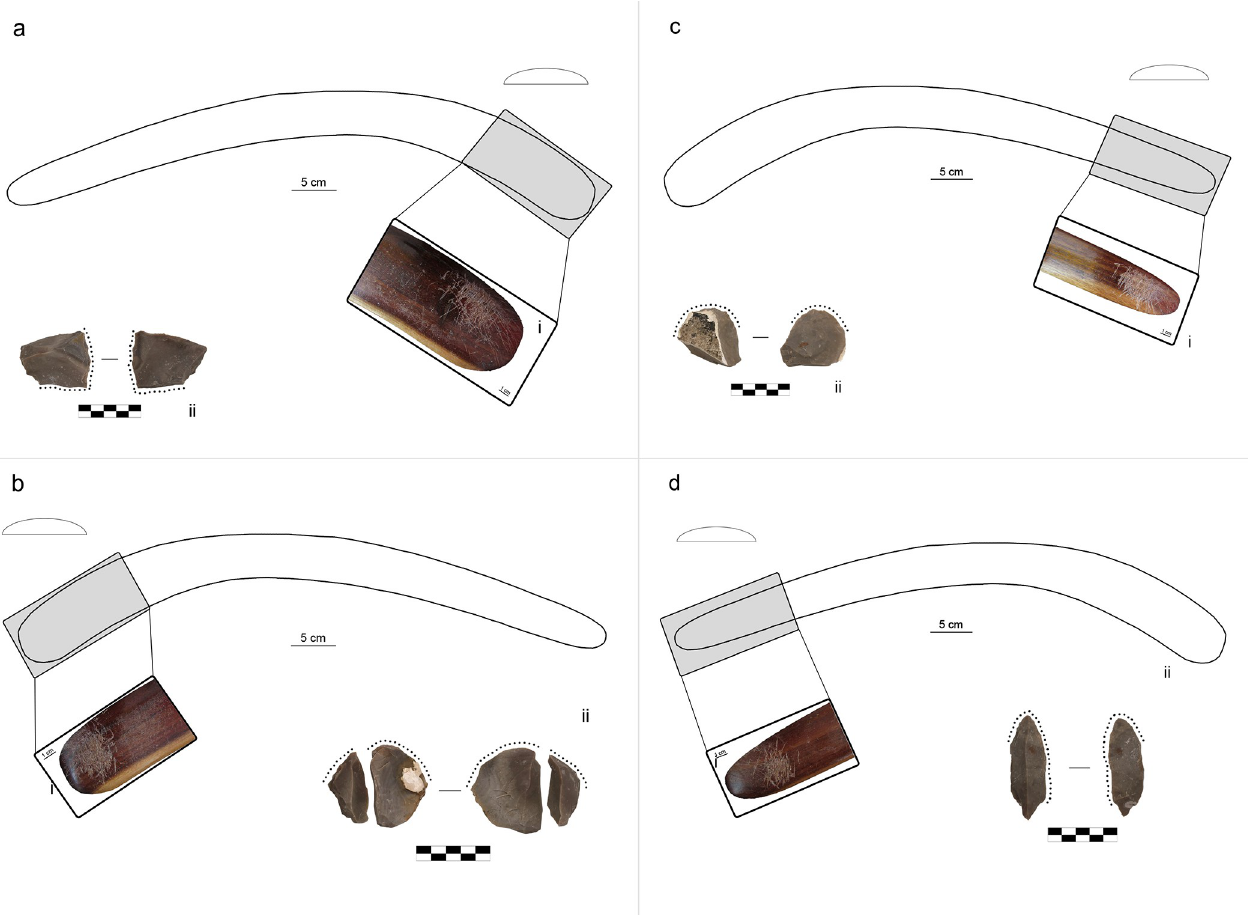
Fig 3. Results of retouching session 2 on the boomerang B2 (plano-convex cross-section and location of use areas). (a) location of use area B2_1, (i) use area B2_1 (1x), (ii) retouched flake F100; (b) location of use area B2_2, (i) use area B2_2 (1x), (ii) retouched flake F71. (c) location of use area B2_3, (i) use area B2_3 (1x), (ii) retouched flake F17; (d) location of use area B2_4, (i) use area B2_4 (1x), (ii) retouched flake F83. https://doi.org/10.1371/journal.pone.0273118.g003 PLOS ONE | https://doi.org/10.1371/journal.pone.0273118 August 16,